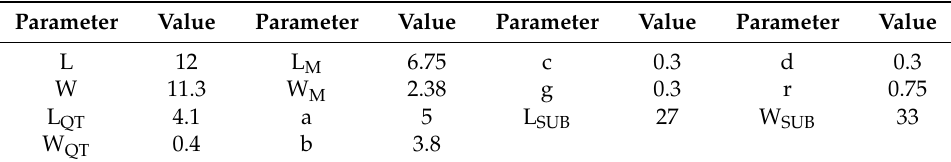
Table 1. Geometrical parameters of CSRR-loaded patch (unit: mm).